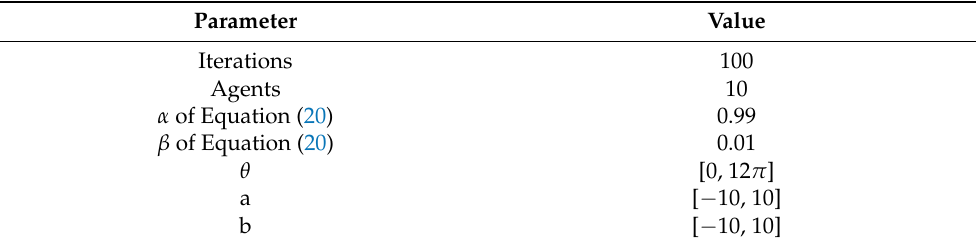
Table 2. Configuration parameters of the proposed feature selection method.